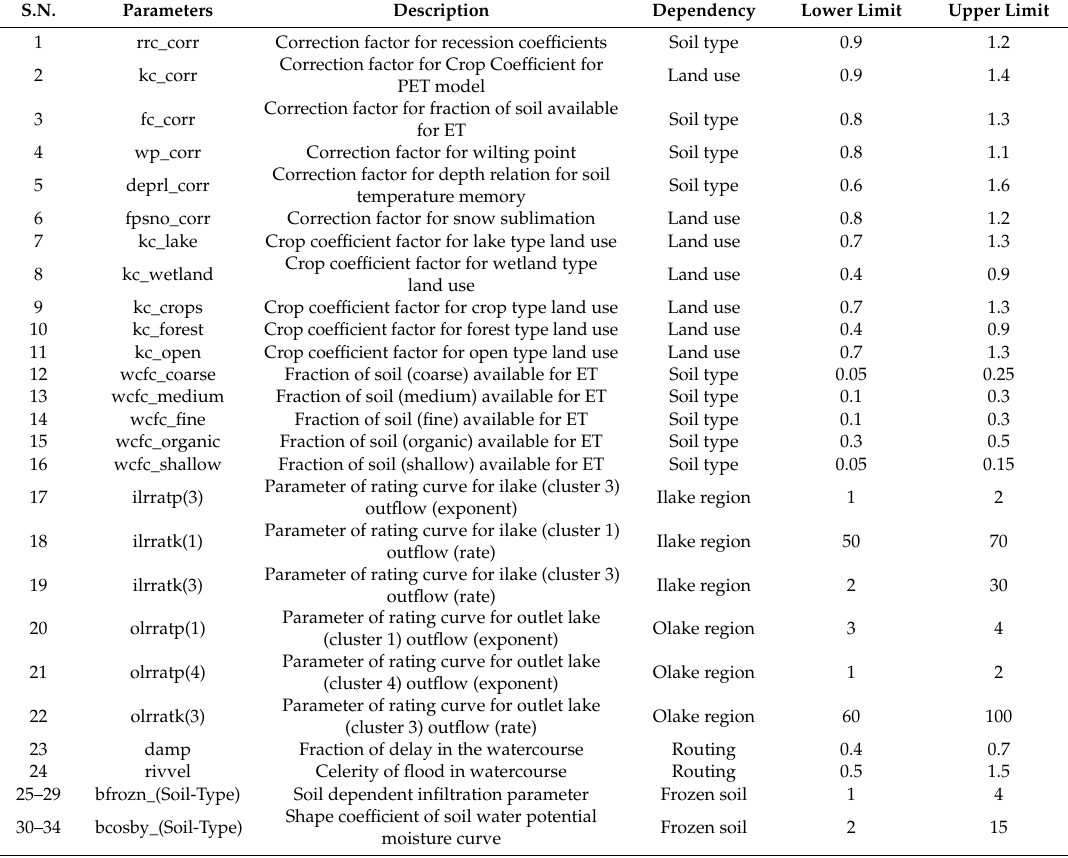
Table 2. Description of parameters in HYPE used for sensitivity analysis with lower and upper limit